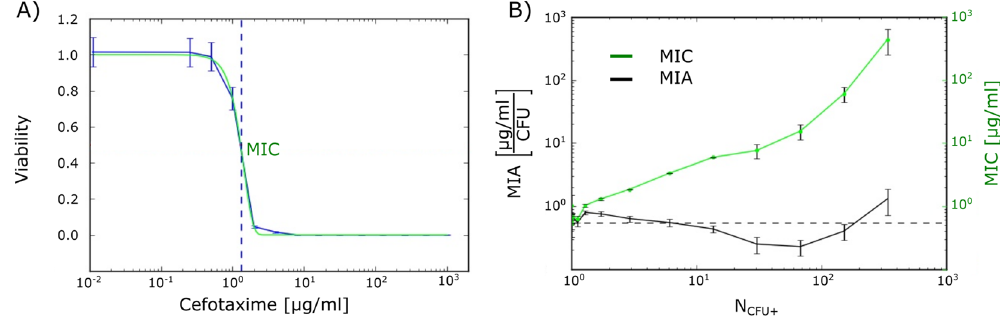
Figure 3. The inhibiting amount of cefotaxime per bacterium remains stable over a wide range of bacterial densities. ( A ) Calculation of MIC using a Gompertz function fit (green line) with bacterial density = . + N 1 73 CFU . Blue vertical dashed line shows the position of the MIC where the Gompertz fit crosses the 0.5 viability fraction in droplets. ( B ) Comparison of MIC (green) and minimum inhibitory amount (MIA; black) for various inoculum densities. MIA is defined as the amount of antibiotic per bacterium inside non-empty droplets normalized by the droplet volume: = + MIA MIC N / . Dashed line shows the average CFU